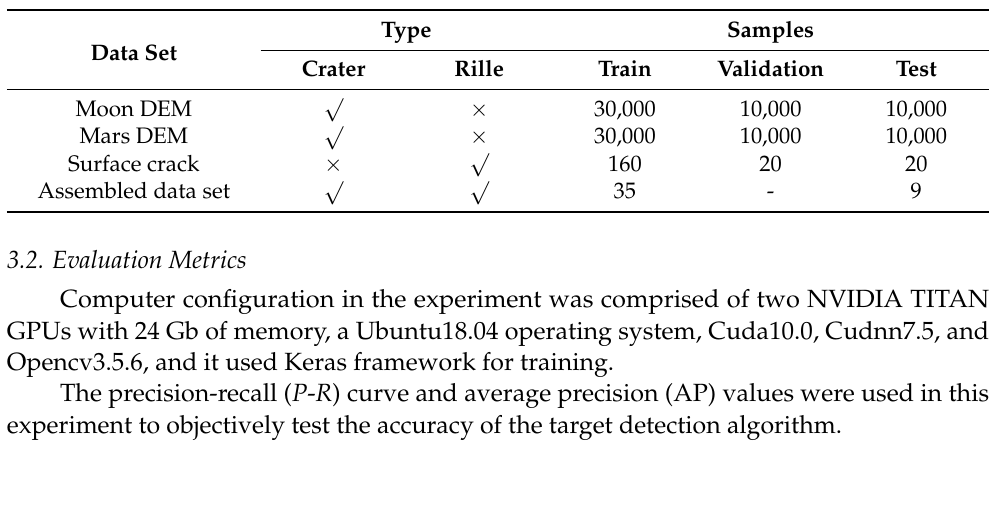
Table 1. Four different types of data sets for training, validation, and